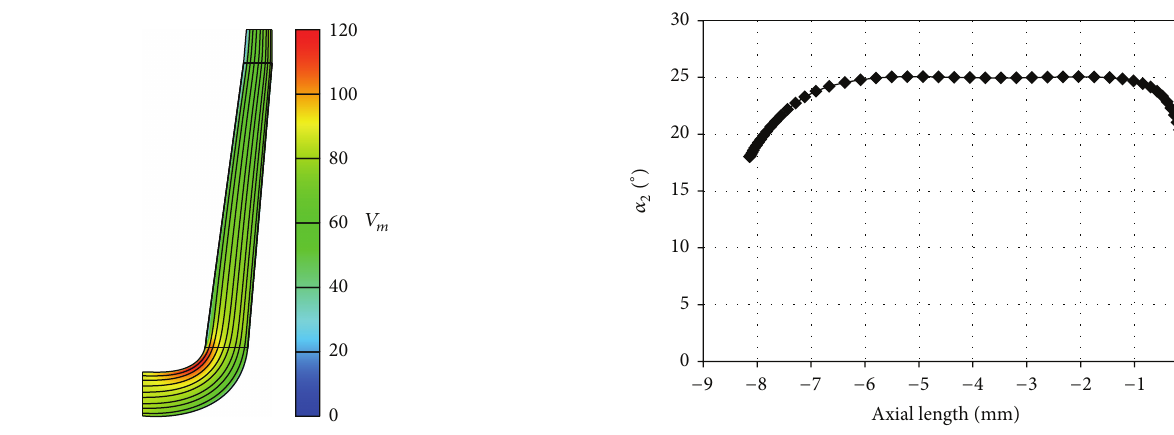
Figure 12: Relative Mach number map.